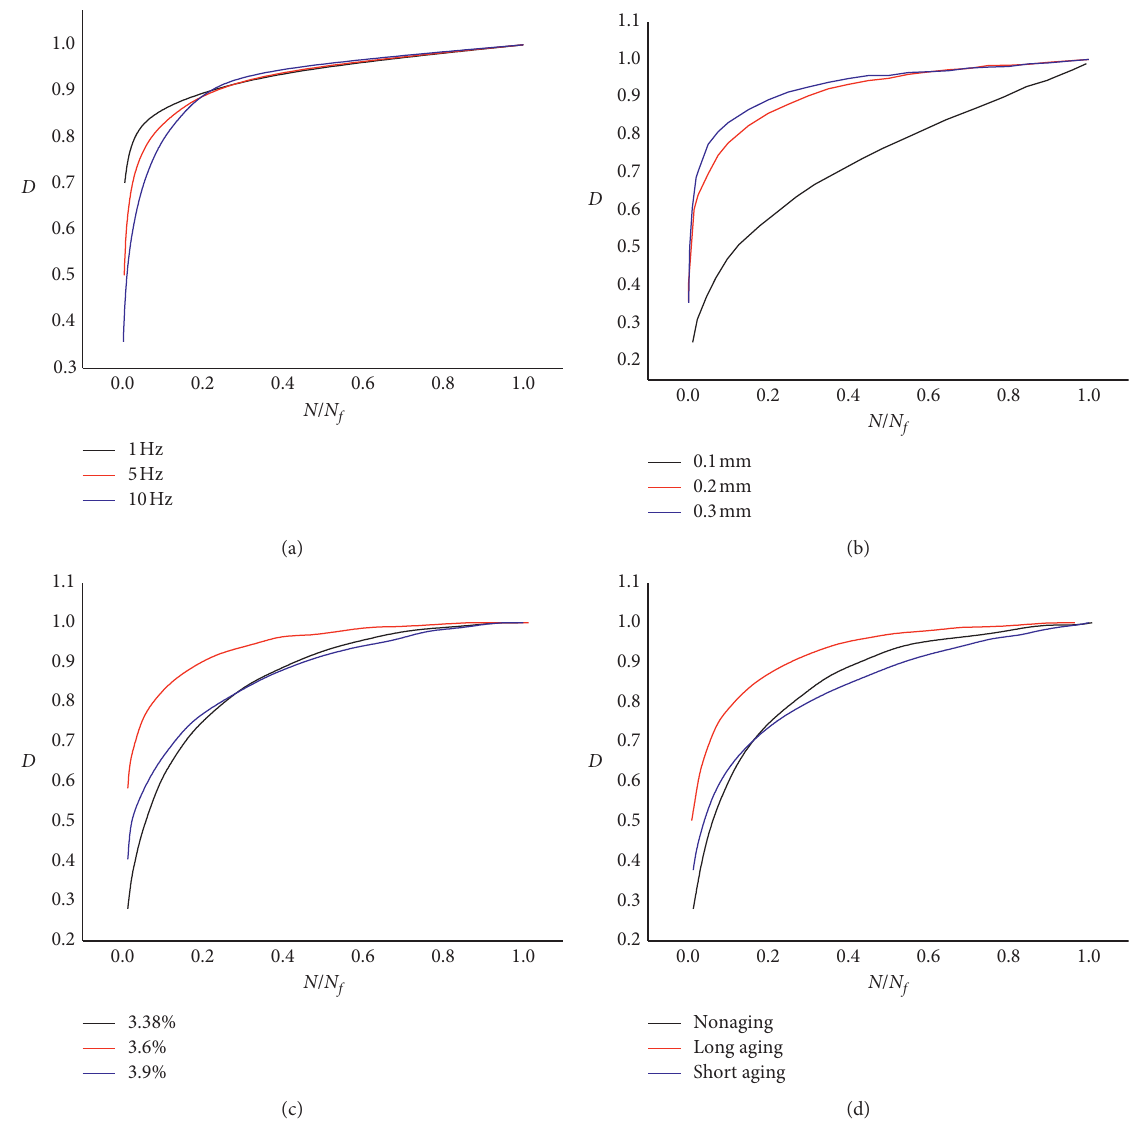
Figure 5: Disturbance D characteristic curves corresponding to the (a) frequency, (b) loading displacement, (c) asphalt-aggregate ratio, and (d) aging degree.